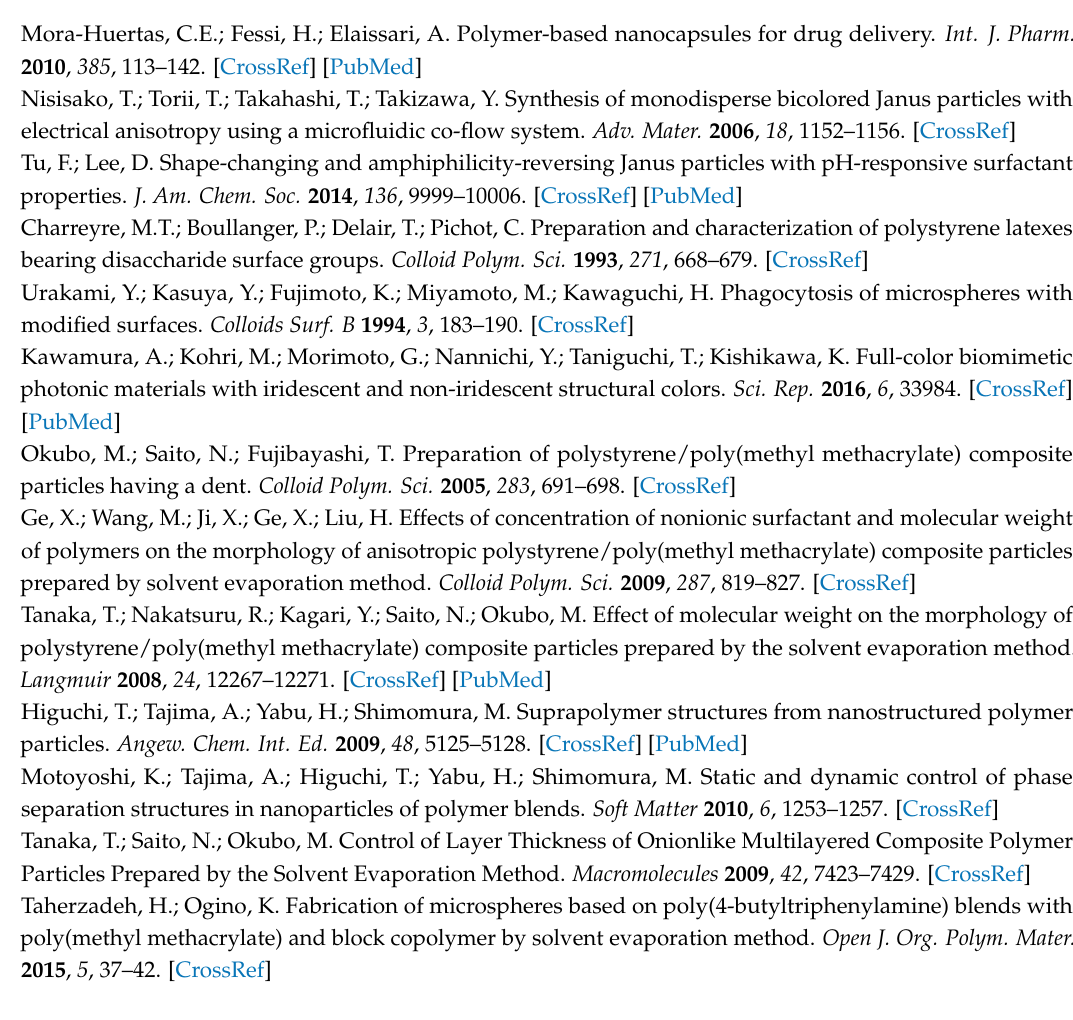
Figure S1: SEM (expanded) (a) and TEM (b) images of microspheres of PBTPA/PMMA prepared with the condition A1 as listed in Table 1, Figure S2: Surface SEM image of microspheres of PBTPA/PMMA prepared with the conditions B1(a) and C1(b) as listed in Table